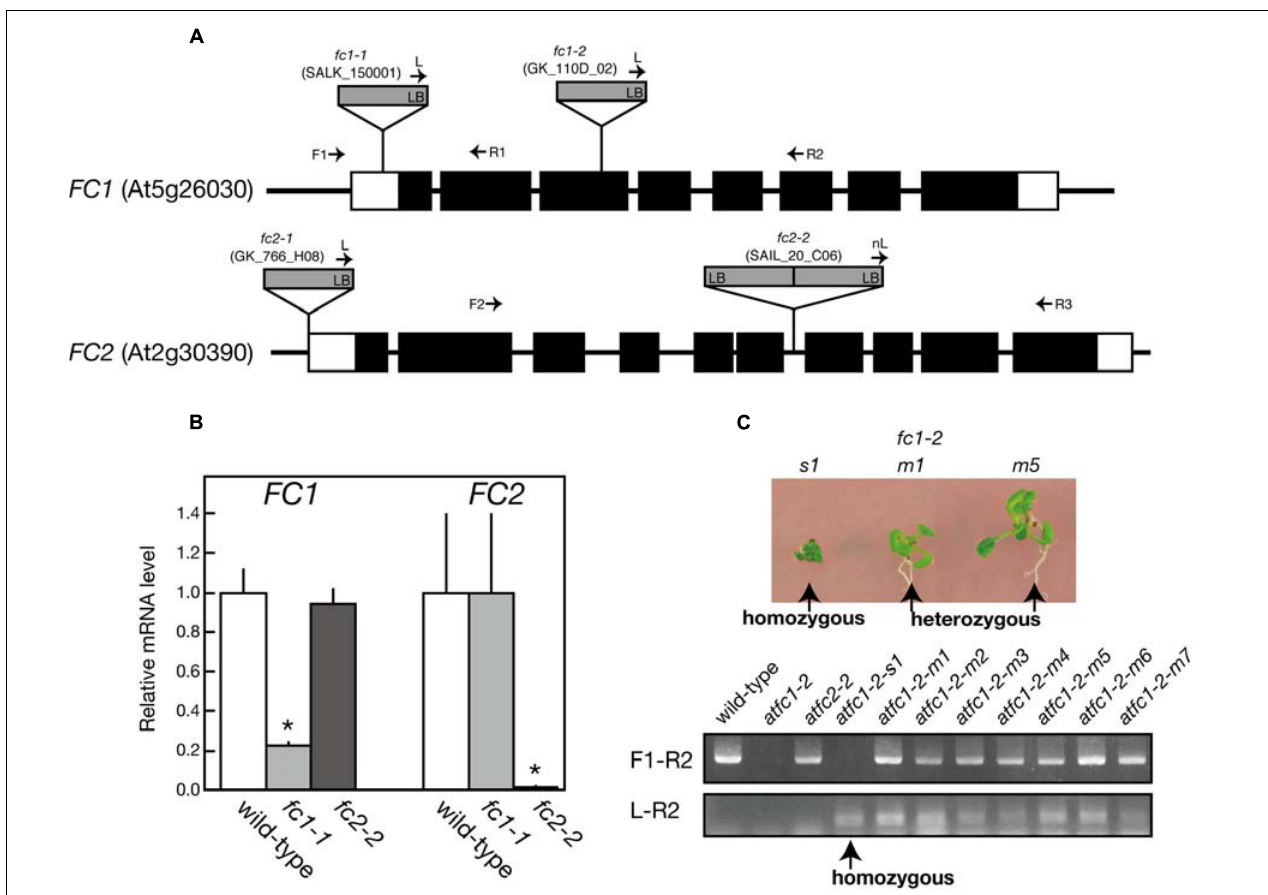
FIGURE 1 | Characterization of T-DNA insertional mutants of ferrochelatase isoforms. (A) Schematic representation and T-DNA tagging of FC1 (At5g26030) and FC2 (At2g30390) loci. Exons (black boxes) and untranslated regions (white boxes) are shown. Location and orientation of T-DNA insertions in each line are indicated. Arrows represent the primers used for genotyping of FC1 and FC2 (see Supplementary Table 1). (B) qRT-PCR analysis of FC1 and FC2 mRNA transcripts extracted from 7-day-old wild type, fc1-1 , and fc2-2 seedlings. Values are presented as the fold difference from the wild-type after normalizing to the control gene ACTIN8 . Bars indicate standard error of the mean (SEM) from three independent experiments. Asterisks indicate a significant difference from the wild-type ( ∗ P < 0.05, Student t -test). (C) Phenotypic and genomic analysis of fc1-2 . (Upper) Photographs of small ( s1 ) and middle ( m1 and m5 ) size seedlings germinated from heterozygous fc1-2 seeds. (Lower) PCR-based genomic analysis of these seedlings, showing small size seedling ( s1 ) is actually homozygous fc1-2 seedling.